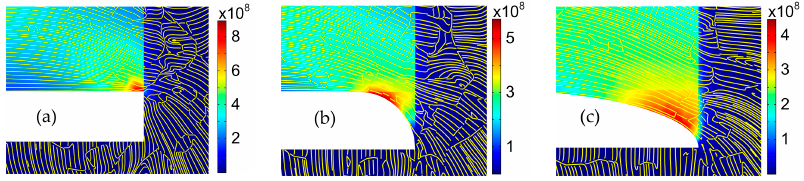
Figure 4. Distributions of stresses and stresses streamlines in SF ( a ); CF ( b ); and OF ( c ) structures.